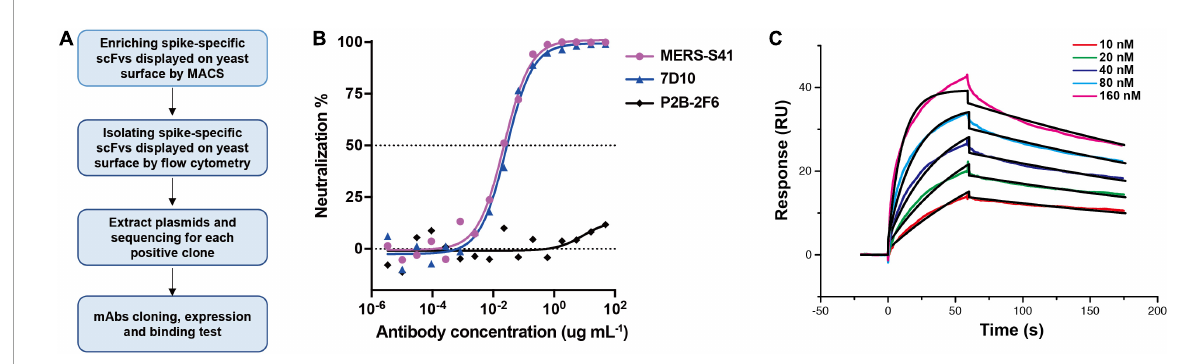
FIGURE1 Antibody MERS-S41, isolated from a scFv yeast display library, has potent neutralizing activity. (A) The selection flowchart. (B) Neutralization of the MERS-S41 IgG against pseudotyped MERS-CoV. Antibody 7D10 IgG targets NTD of MERS-CoV S and P2B-2F6 targets RBD of SARS-CoV-2, as positive and negative controls, respectively. (C) Surface plasmon resonance curves showing binding of MERS-CoV spike glycoprotein to immobilized MERS-S41 IgG. Data are shown as different colored lines and the best fit of the data to a 1:1 binding model is shown in black.